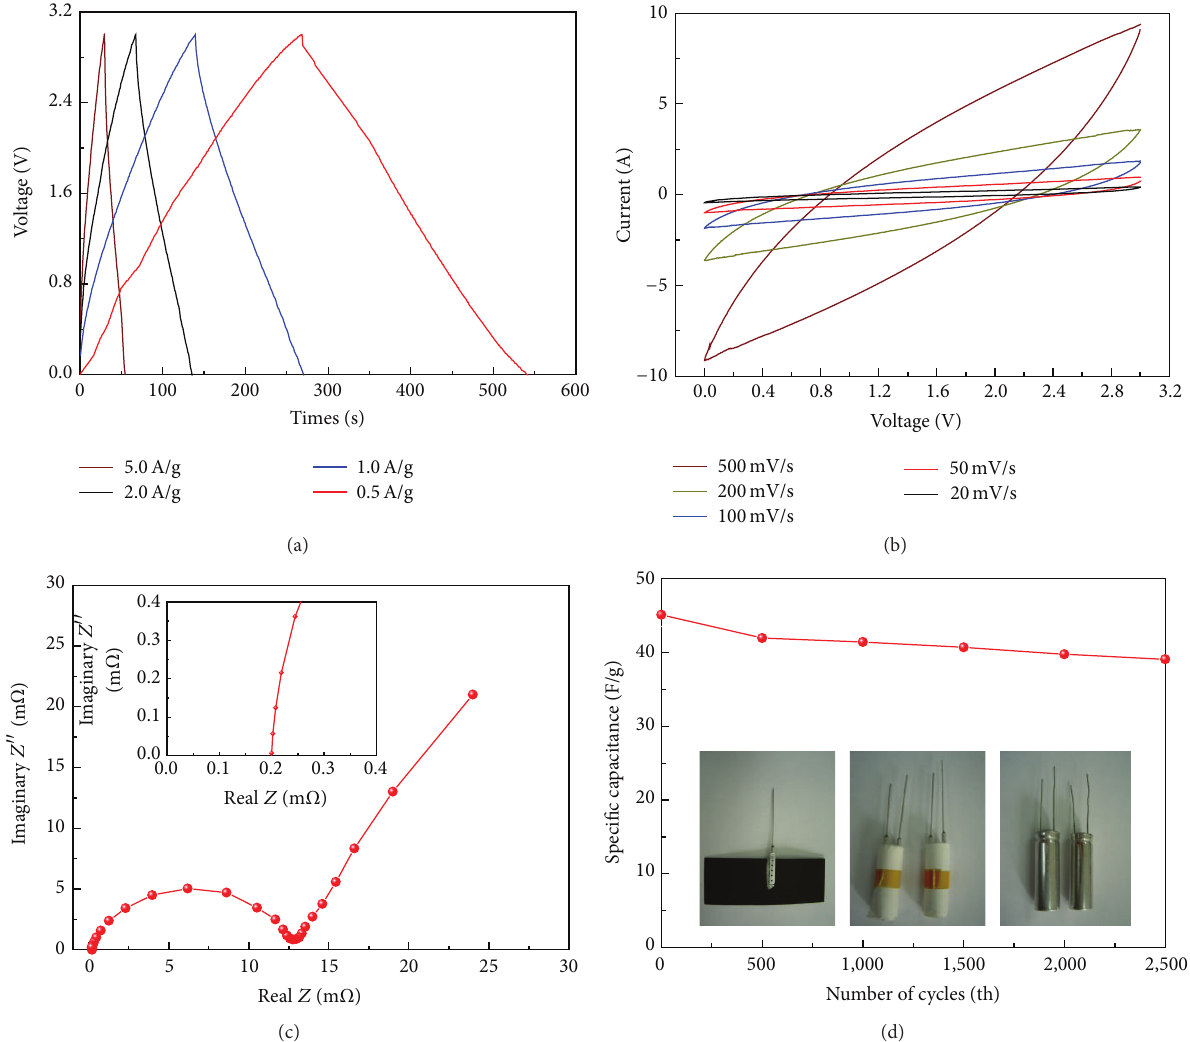
Figure 3: Electrochemical analysis of the supercapacitor based on PPy/AC composite electrode in nonaqueous electrolyte. (a) Galvanostatic charge-discharge profile at different current density. (b) CV curves at different scan rates. (c) Nyquist plot. (d) Cyclic stability test up to 2500 cycles at 5 Ag −1 current